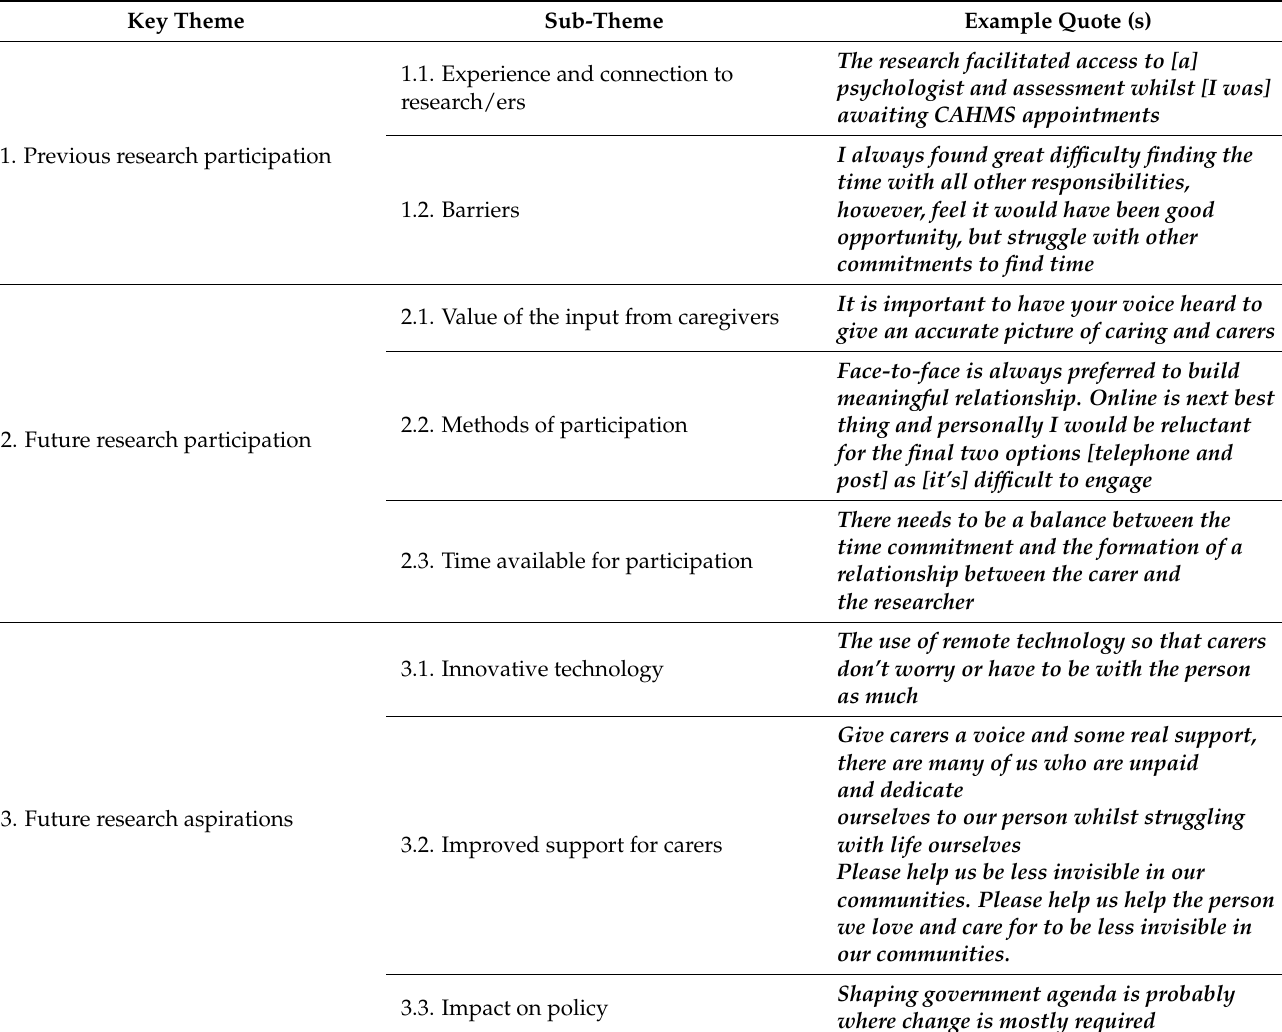
Table 2. Key themes and sub-themes from Caregiver Survey. (CAHMS= Child and Adolescent Mental Health Services). Key Theme Sub-Theme Example Quote